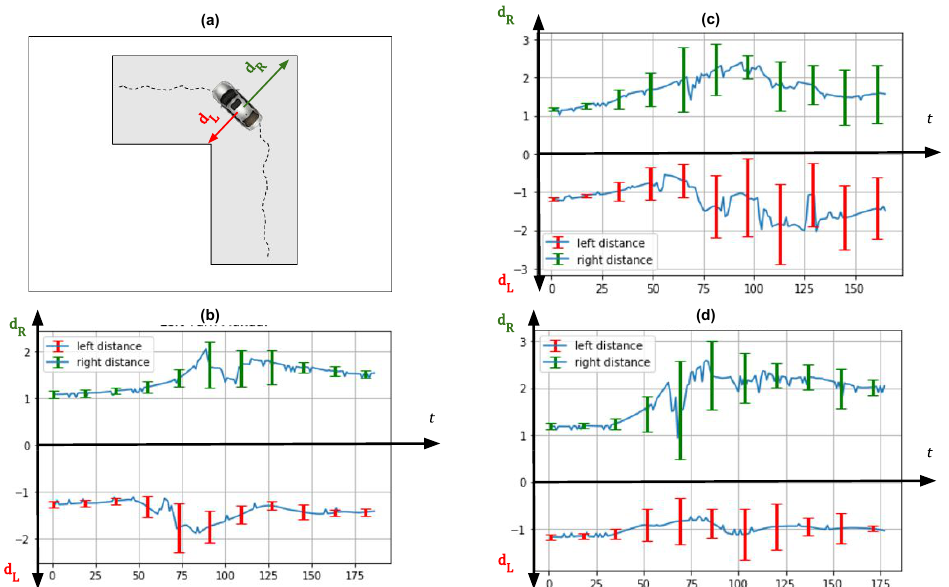
Figure 22. Left turn path performance test curves with error bars. Green error bars are related to the distance between the right wall and the center of the vehicle. Red error bars are related to the distance between the left wall and the center of the vehicle. ( a ) Left turn path. ( b ) Driving by a human operator. ( c ) Driving by the neural network trained with camera images. ( d ) Driving by the neural network trained with LiDAR.